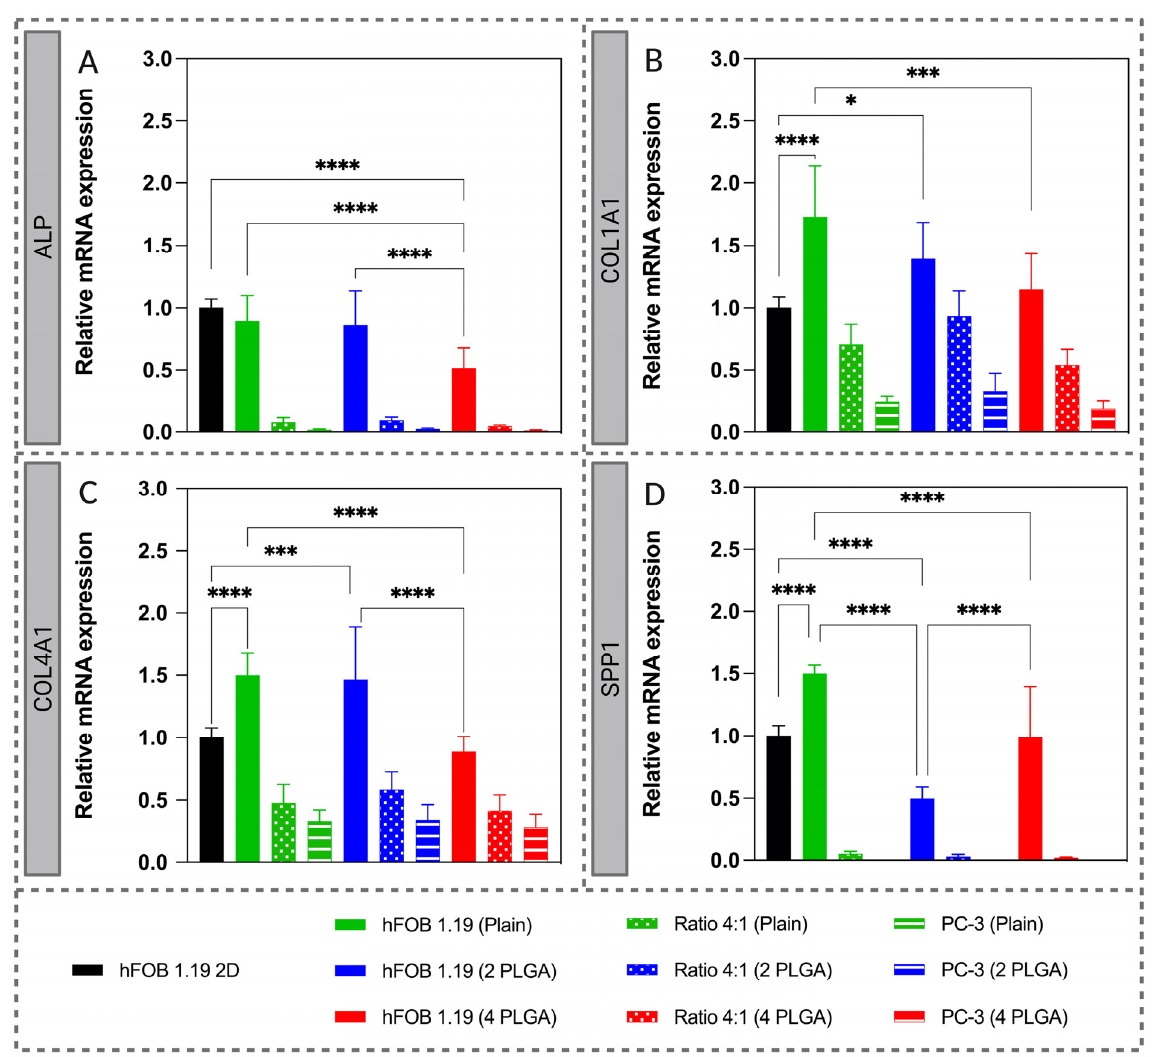
Figure 9. RT-qPCR quantification of the mRNA expression levels of: ( A ) ALP; ( B ) COL1A1; ( C ) COL4A1; and ( D ) SPP1. The relative mRNA expression is expressed as mean ± SD, with hFOB 1.19 2D used as a reference. 2 PLGA refers to 2 mg nHA/PLGA scaffolds, and 4 PLGA refers to 4 mg nHA/PLGA scaffolds. The data represents 2 independent experiments and a total of n = 6 replicates per sample type. * p < 0.05, *** p < 0.001, **** p < 0.0001.